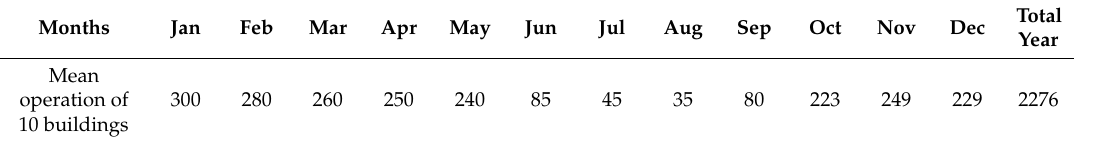
Table 1. Typical operation hours of heating